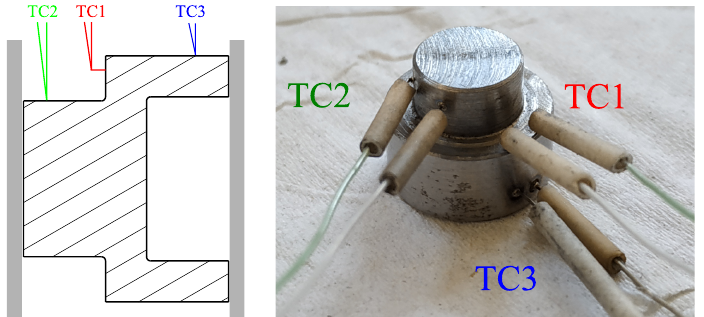
Figure 4. Welding of the thermosensor. The control of the temperature was achieved with the sensor labelled